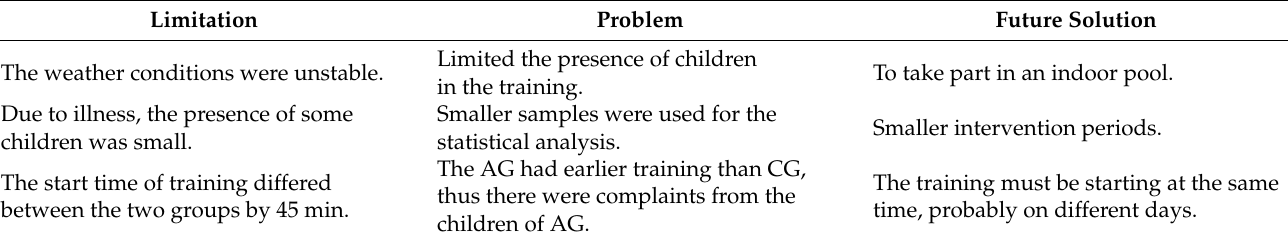
Table 6. Study’s